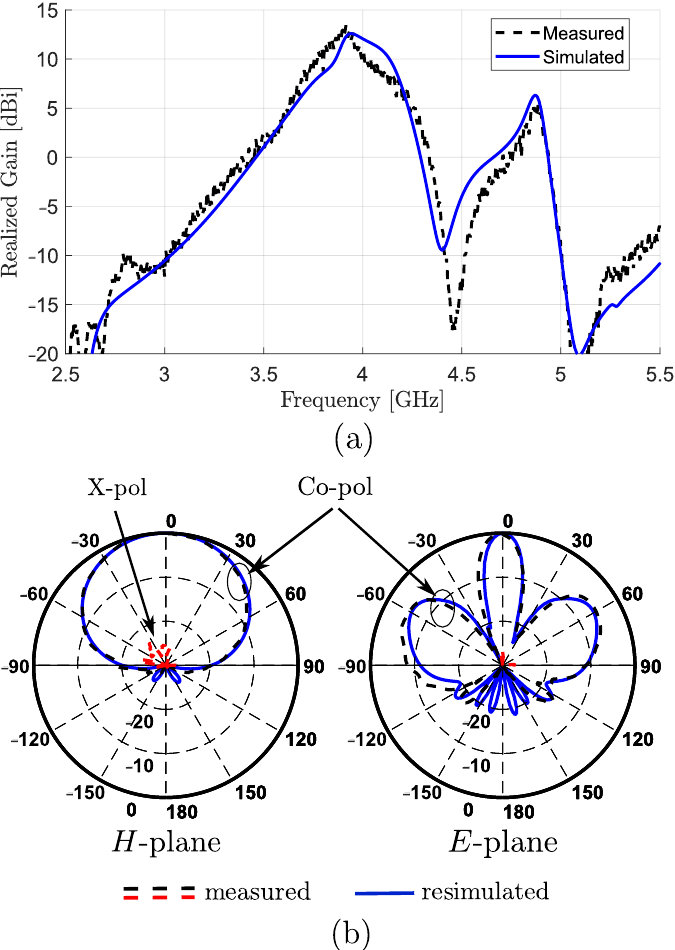
Figure 14. Resimulated and measured: ( a ) realized gain; ( b ) radiation patterns after considering mismatching in dielectric